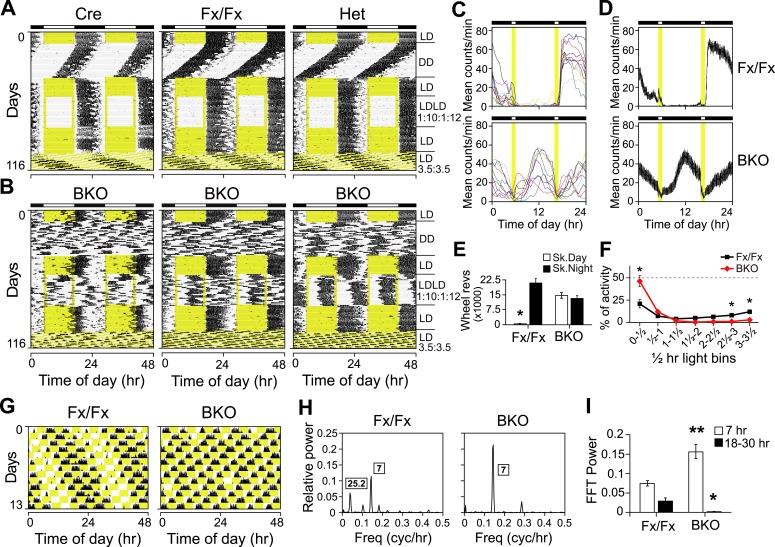
Both entrainment and masking are abnormal in Bmal1 brain knockout mice.(A, B) Representative double-plotted actograms of daily wheel-running activity of Cre, Fx/Fx, Het, and BKO mice. Mice were housed in LD, released into DD for 4 weeks, returned to LD for 2 weeks, introduced to a skeleton photoperiod (LDLD 1:10:1:12) for 4 weeks, returned to LD for 2 weeks, and then switched to an ultradian cycle (LD 3.5:3.5) for 3 weeks. Shown are days 1–24 of the skeleton photoperiod and days 3–15 of LD 3.5:3.5. (C, D) Average activity profiles of Fx/Fx (n = 12) and BKO littermates (n = 10) during LDLD 1:10:1:12. (C) Average profiles for individual mice; (D) the ensemble average for the entire group. Each data point represents counts per minute averaged across a 6-min bin (±SEM for D). (E) Total activity counts (mean ± SEM) during 10 hr of subjective day (Sk. Day) and 10 hr of subjective night (Sk. Night) of LDLD 1:10:1:12. In contrast to Fx/Fx littermates, BKOs are equally active during skeleton day vs skeleton night. *p < 0.0001 by t-test. (F) Masking of BKO (n = 14) and Fx/Fx littermates (n = 9) during specific 0.5 hr light bins of LD 3.5:3.5. Total activity (mean ± SEM) during each 30 min light bin is divided by the total of that bin plus the corresponding dark bin. Thus the first data point for each genotype represents the distribution of activity between the first 30 min of light and the first 30 min of dark. There was a significant interaction between the genotype and time using Repeated Measures GLM ANOVA [F1,160 = 22.3, p < 0.0001]. Specifically, days 1, 6, and 7 were found to be significantly different by Tukey–Kramer multiple comparison post-tests (*p ≤ 0.05). (G) Representative double-plotted actograms of daily wheel-running activity of Fx/Fx (left) and BKO (right) littermates. These are the same mice as those shown in (A, middle panel) and (B, middle panel), respectively. Light phases are indicated in yellow to show the structure of the LD 3.5:3.5 cycle as well as to help visualize the occurrence of wheel-running activity under this schedule. Note that, after 1 week of this cycle, initial phase relationships are regained. (H) Representative amplitude power spectra of Fx/Fx and BKO mice, from FFT analyses performed on the same activity records shown in (G). The highest peaks for both genotypes were in the 7-hr range, corresponding to the LD 3.5:3.5 schedule. The second-highest peak for the controls was in the circadian (18–30 hr) range (left). None of the BKOs was found to have a period in the circadian range (right). (I) Group averages of amplitudes in the 7-hr range and in the circadian range for the same Fx/Fx and BKO mice as in (F). Compared to controls, BKOs had significantly higher amplitude in the 7-hr range (**p < 0.0001 by t-test) and significantly lower amplitude in the circadian range (*p < 0.0060 by t-test).